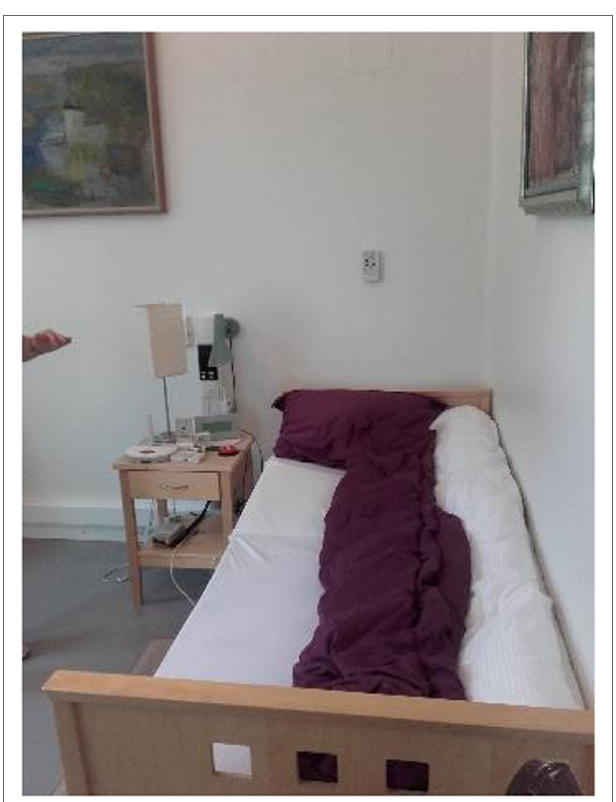
FigUre 2 | Bed where the flat pressure sensitive sensor has been concealed under the white